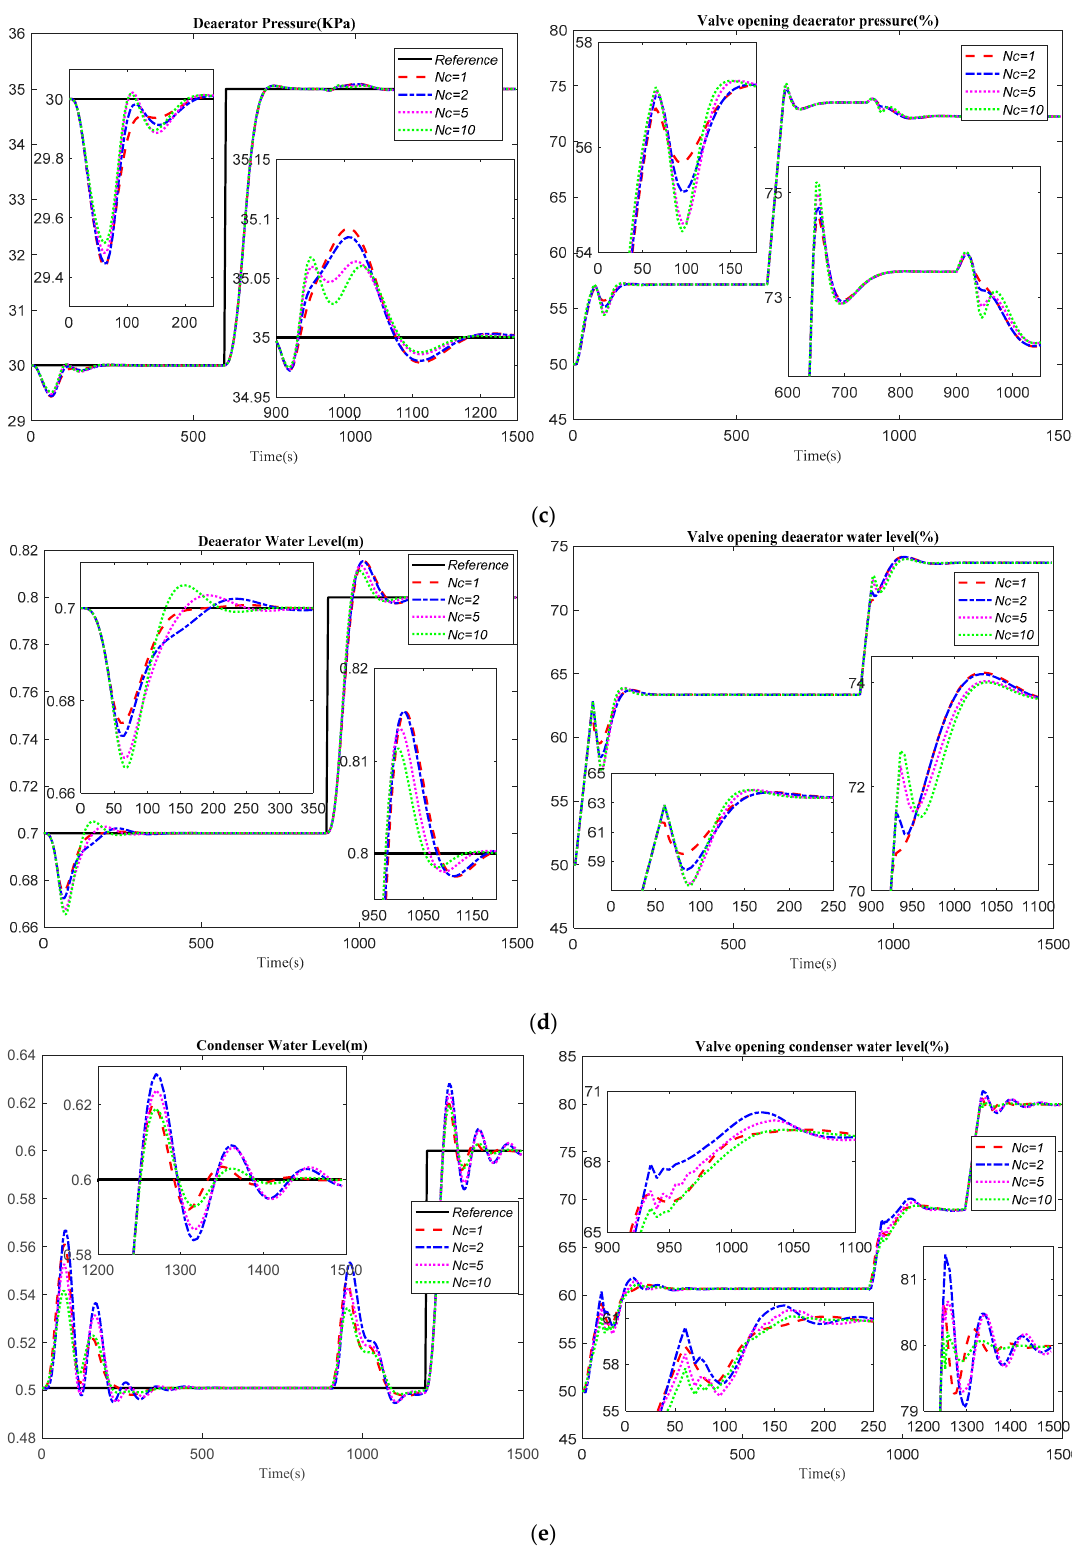
Figure 4. Responses of the steam/water loop under the ripple-free EPSAC for different control horizons for ( a ) drum water level control loop, ( b ) deaerator water level control loop, ( c ) deaerator pressure control loop, ( d ) condenser water level control loop and ( e ) exhaust manifold pressure control loop (The figures on left-hand indicate the outputs, and on the right-hand indicate the inputs). The performance of the proposed ripple-free EPSAC algorithm was also analyzed in terms of the integrated absolute normalized tracking error ( E i ) and computation time ( T i ) defined in Section